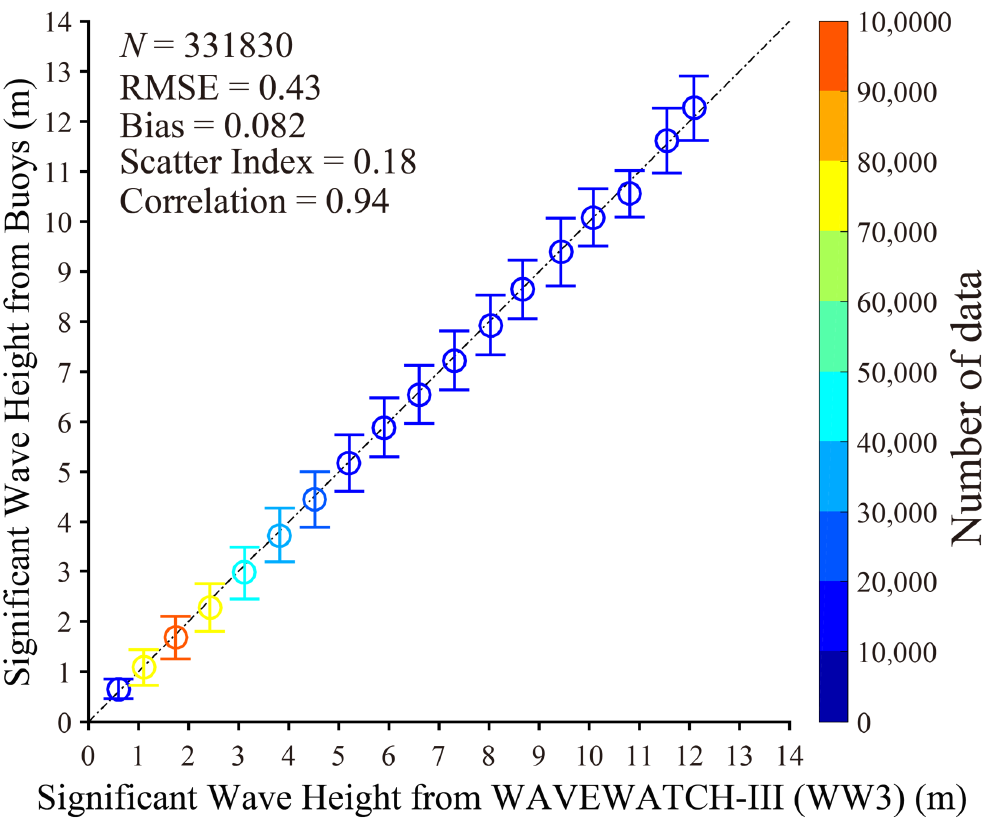
Figure 2. Comparison from WAVEWATCH-III (WW3)-simulated significant wave height (SWH) with the measurements from NDBC buoys, in which the error-bars represent the standard deviation of each bin at a 0.5 bin from 0 to 14 m of SWH.